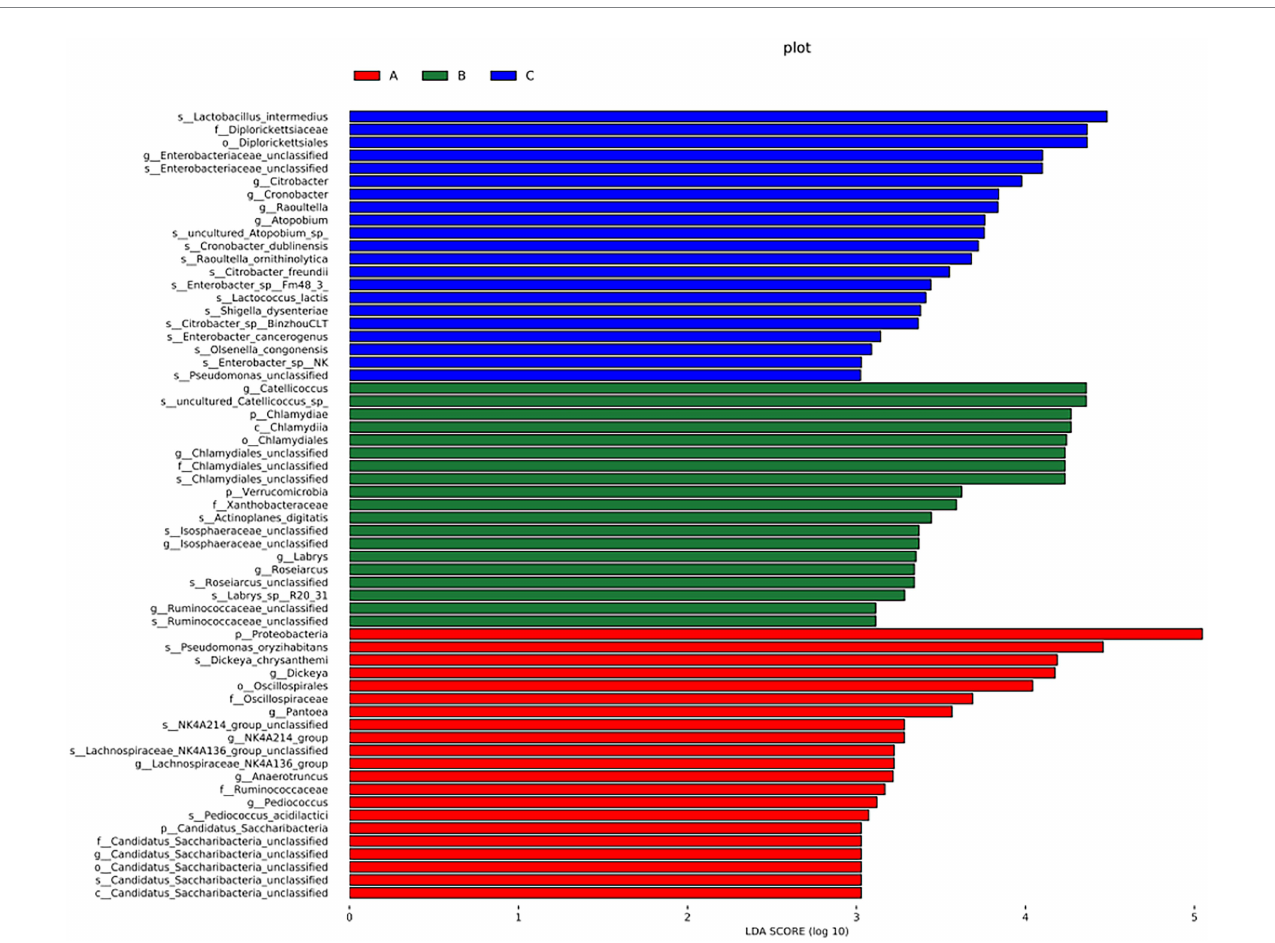
FIGURE 6 LDA demonstrated distinct bacterial genera enriched in the three groups. The color of the bar chart represents the higher abundance of different species in each group, and the length represents the influence degree of significant differences between different